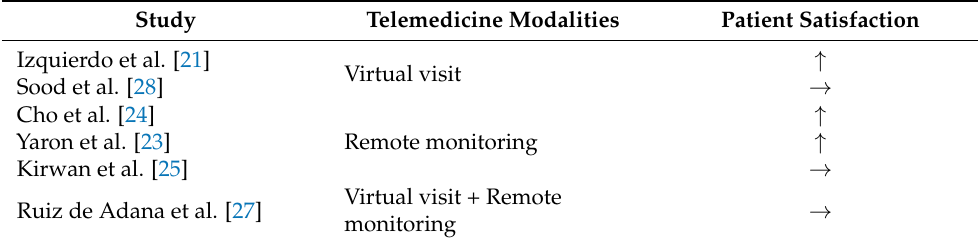
Table 3. The relationship between patient satisfaction and telemedicine modalities.